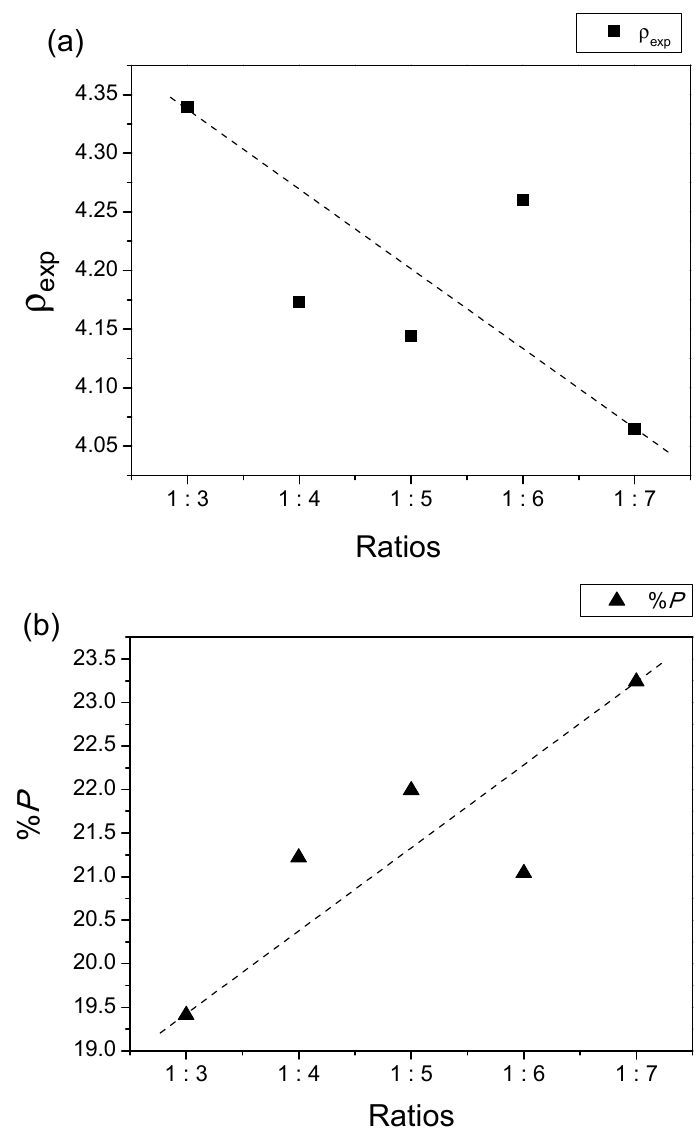
Figure 2. Relationships of ( a ) density, ρ exp and ( b ) Percentage of porosity, %P of BaFe 12 O 19 .